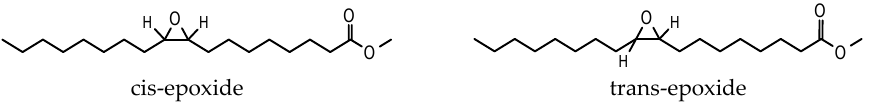
Figure 10. Chemical structure of cis-epoxide (left) and trans-epoxide (right). The steric is determined by the hydrogens [17,32,33].